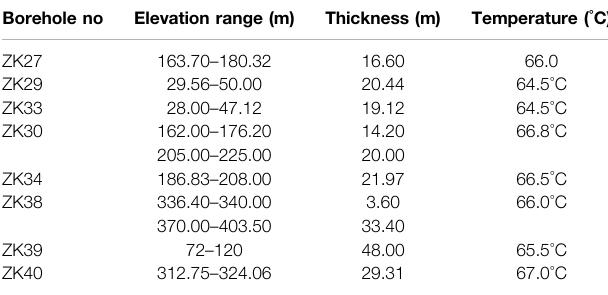
TABLE 1 | Key results of the pumping test that was carried out in the Wentang geothermal fi eld (WGF) over the years. Time